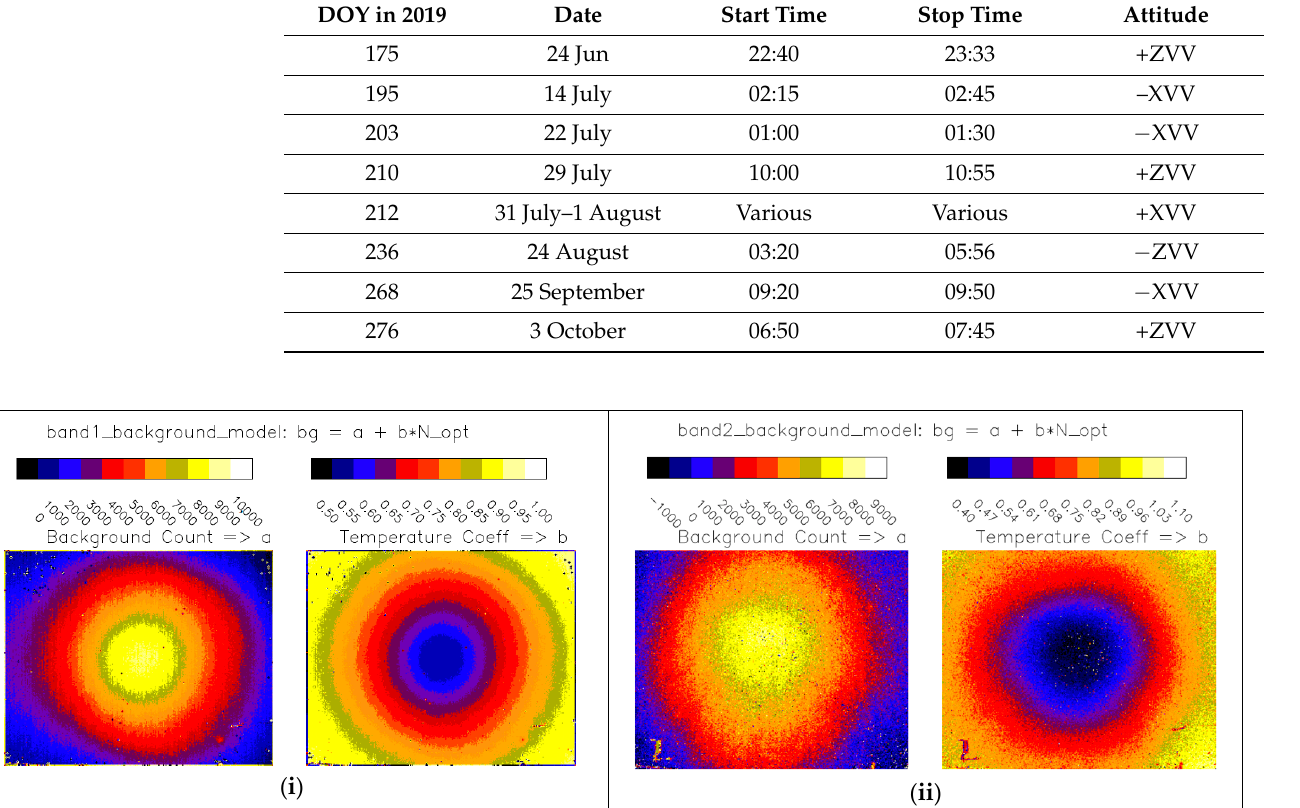
Table A1. ISS pitch-up/down days used by CTI for deep-space calibration.